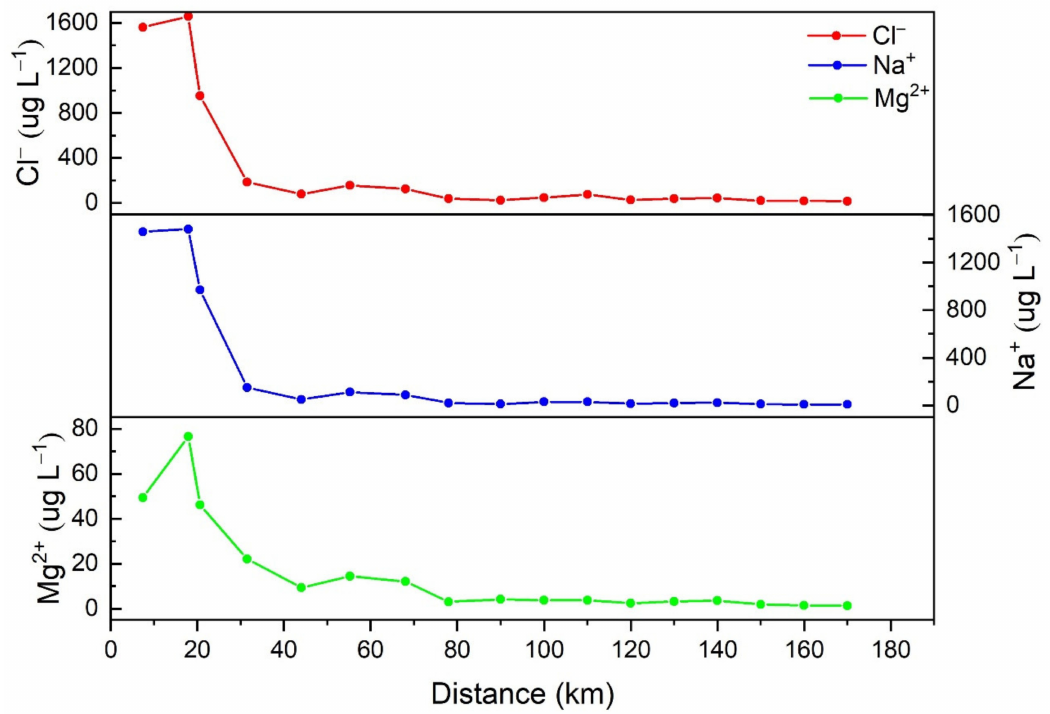
Figure 3. Concentration variations of Cl − , Na + , and Mg 2+ with increasing distance from the coast. Each point represents the value of one surface snow sample for each site, unless otherwise